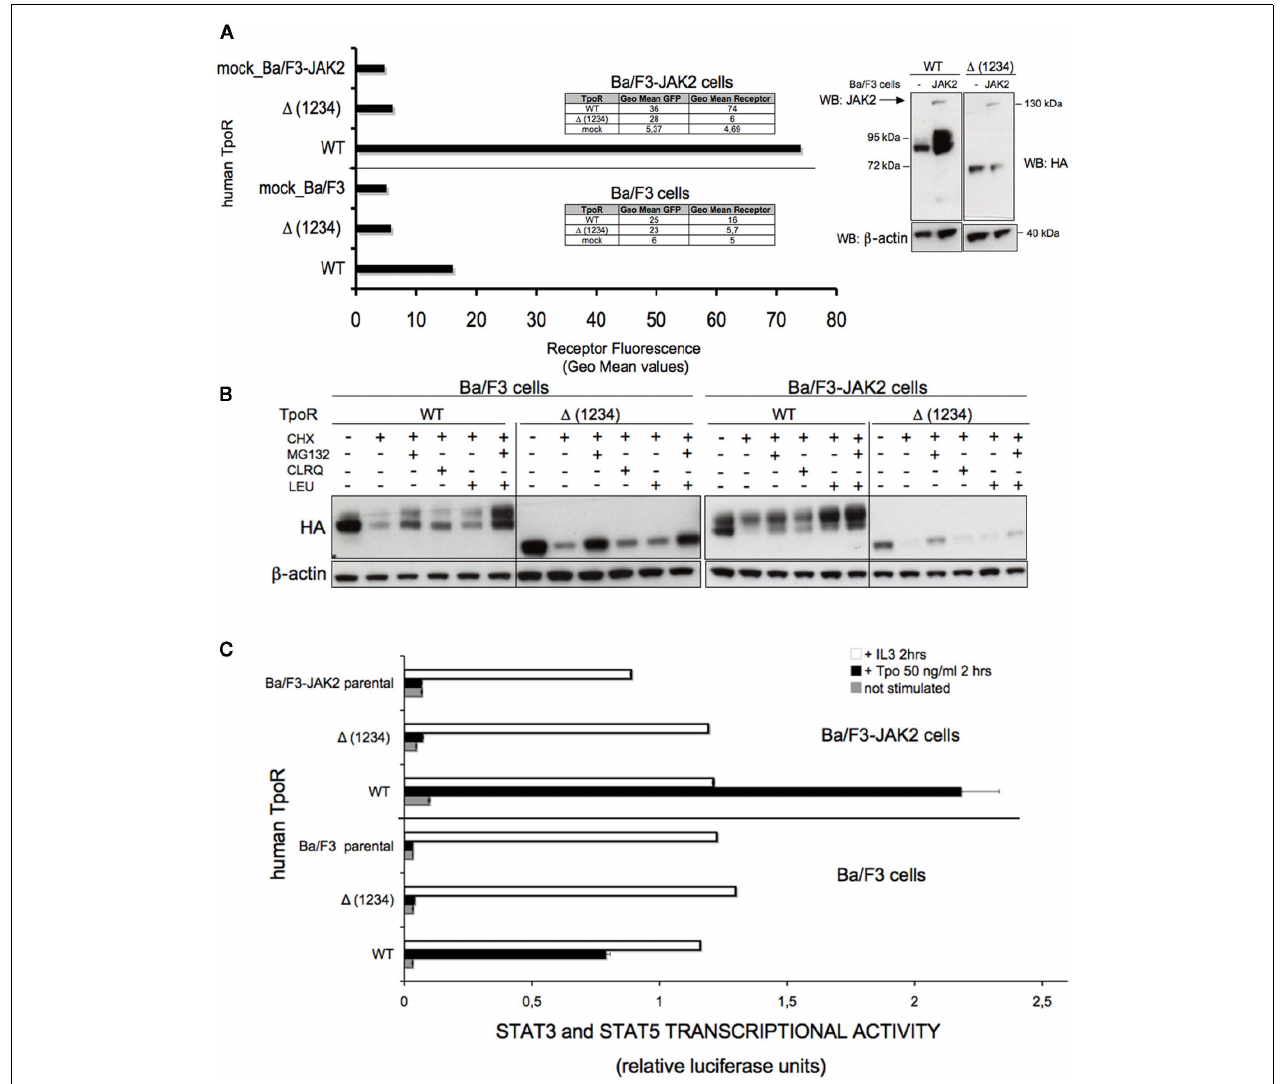
MG132 (10 μ M) or with 50 μ g/ml cycloheximide and lysosome inhibitors (200 μ M chloroquine or 10 μ g/ml leupeptin). Control cells were kept untreated to have 100% protein expression. Cells were lysed and analyzed byWestern blotting with antibodies against HA for the levels ofTpoR and anti- β -actin as a loading control. (C) Pools from the same cell lines used in (A,B) were starved 3h in RPMI medium + 1mg/ml BSA and electroporated with pGRR5-luc and pRLTK-luc reporters.The cells were also stimulated withTpo or left unstimulated during 2h at 37˚C. Upon treatment the cells were lysed and their luminescence recorded. Results are the mean ± variation of triplicate samples. One of three independent experiments is depicted.The t -test showed statistically significant differences between theTpo-dependent transcriptional activities level of the Δ (1234)TpoR and that ofWTTpoR ( p < 0.0001 for both Ba/F3 and Ba/F3-JAK2 cell lines).